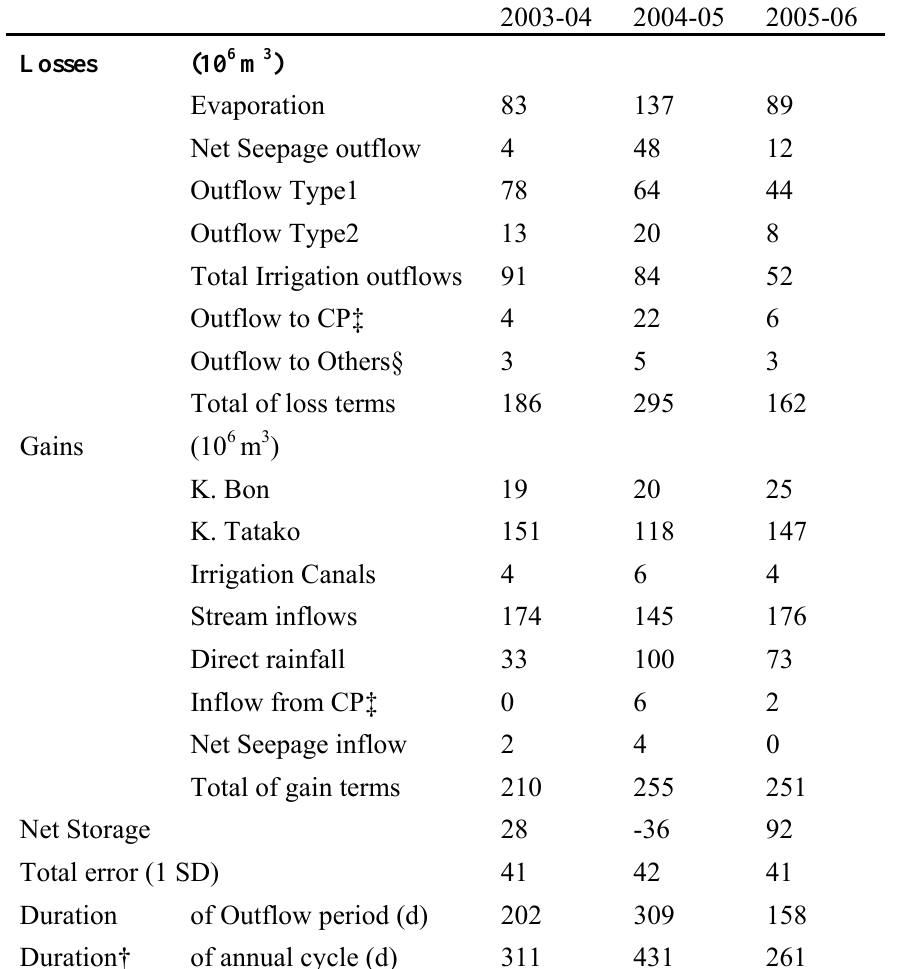
Table 3. Summary of water balance components for three inflow/outflow